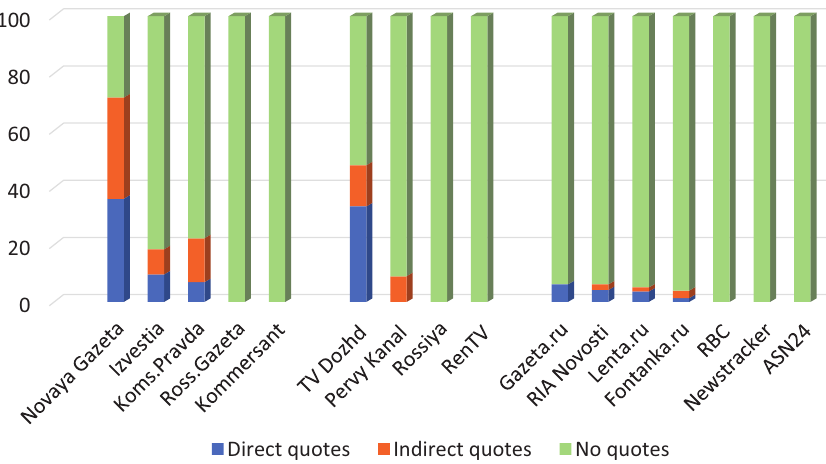
Figure 4. Percentages of publications focusing on, and giving voice to, immigrants into Russia. Notes: Three groups of media, left to right—newspapers, TV channels, online media; Koms.Pravda = Komsomolskaya Pravda ; Ross.Gazeta = Rossiyskaya Gazeta